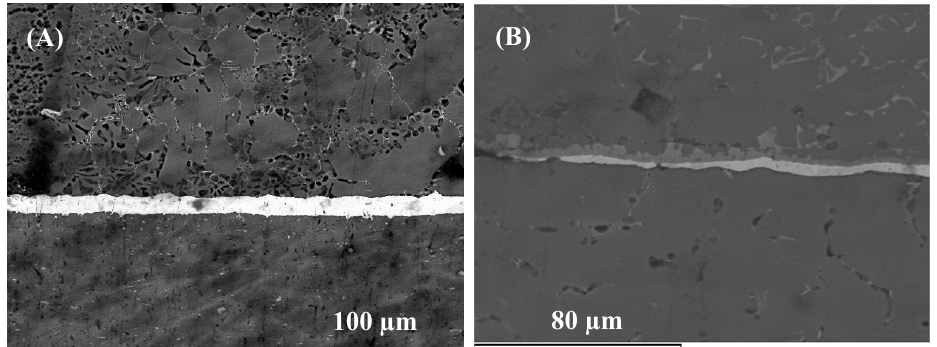
Figure 7. ( A ) SEM micrograph of Mg/Al joint bonded for 10 min using pure-Cu interlayer ( B ) Detail view of the interface.